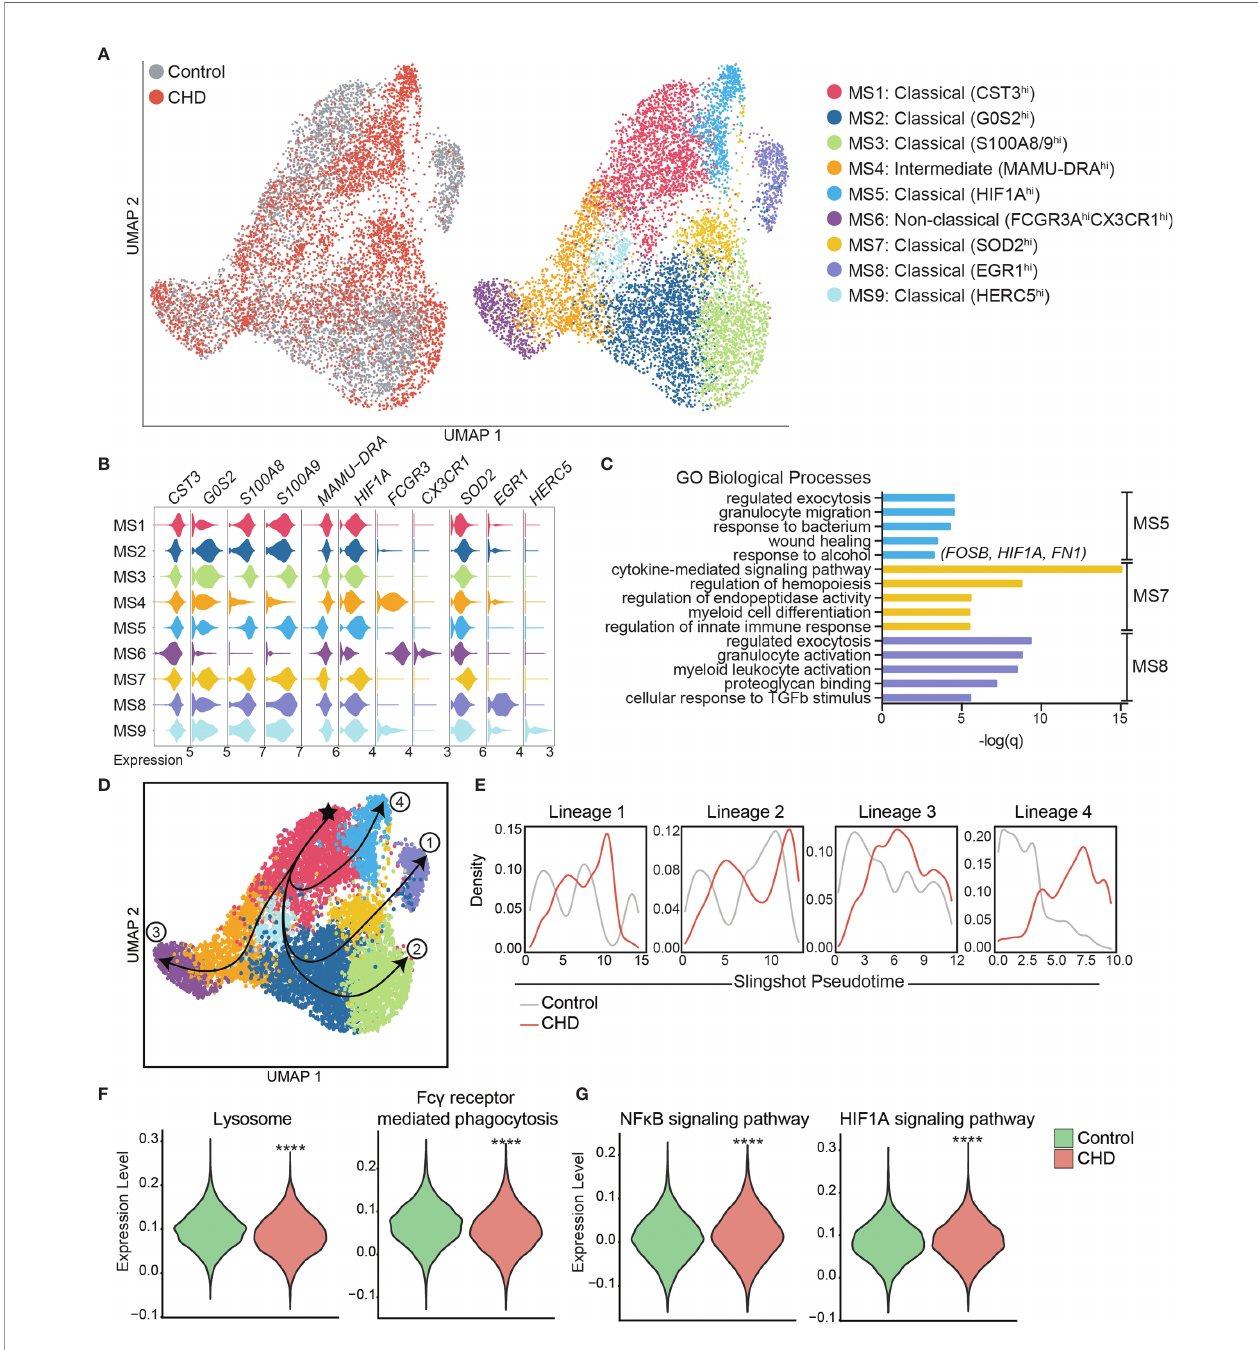
FIGURE 3 | Single cell RNA-Seq analysis of monocytes with CHD. Monocytes (n = 3 control/3 CHD) were puri fi ed from total PBMC from female macaques and subjected to 10X scRNA-Seq analysis. (A) Visualization of 9,360 monocytes by uniform manifold approximation and projection (UMAP) colored by group (control and CHD) as well as by identi fi ed clusters. (B) Stacked violin plots representing expression of key genes used for cluster identi fi cation, grouped by monocyte subset cluster. (C) GO Biological Process enrichment from Metascape of genes highly expressed in MS5, MS7, and MS8, de fi ned by q-value. (D) Trajectory analysis of monocytes determined using Slingshot. (E) Cell density plots for Control and CHD groups across each of four trajectory lineages determined by Slingshot. (F, G) Violin plots comparing (F) Lysosome and Fc g receptor-mediated phagocytosis and (G) NFkB signaling and HIF1A signaling pathway module scores in all monocytes of both groups. Statistical analysis of module scores was performed using a t-test with Welch ’ s correction where ****p <